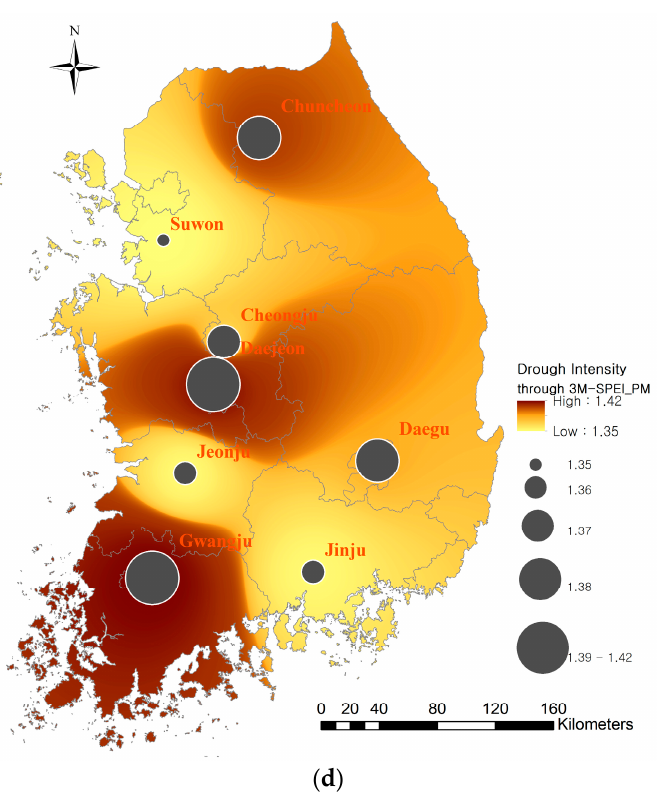
Figure 4. Intensity of drought obtained by applying SPEI_th and SPEI_pm to runs theory. ( a ) Intensity of drought based on 1-month SPEI_th., ( b ) Intensity of drought based on 1-month SPEI_pm., ( c ) Intensity of drought based on 3-month SPEI_th, ( d ) Intensity of drought based on 3-month